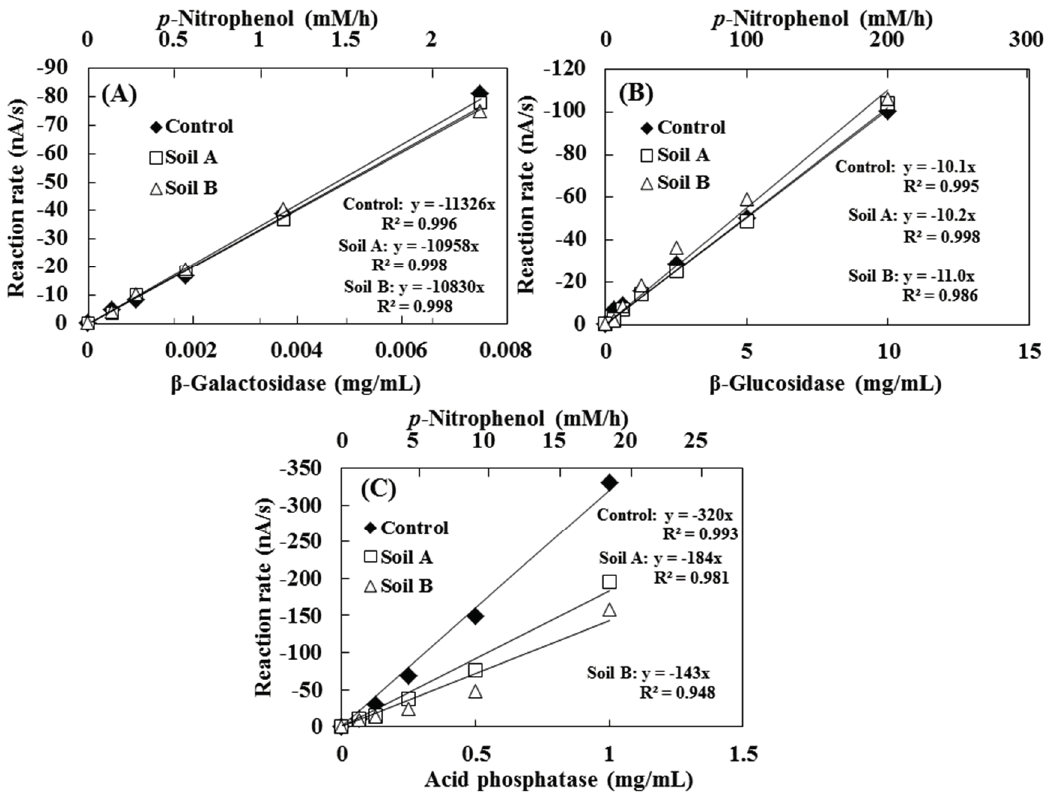
Figure 4. The calibration curve for ( A ) β -gal; ( B ) β -glu and ( C ) AcP solutions spiked in real soils. The original enzymes in the soil samples were inactivated in an autoclave at 121 °C for 20 min. The concentration of the p -nitrophenol released from the enzyme reaction was measured using standard assay